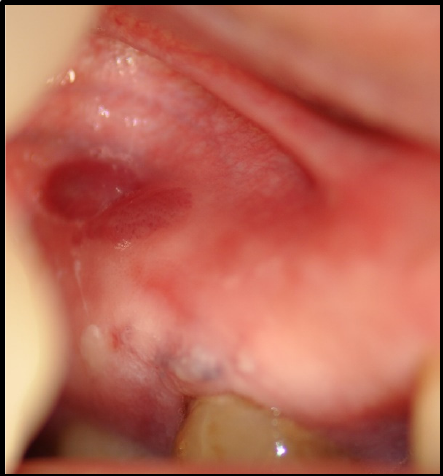
Figure 2. Hemorrhagic blisters, right buccal gingivae, consistent with benign mucous membrane pemphigoid. The patient, on pembrolizumab, presented with pain and dysphagia. Three patients had lesions which were exacerbations of previous oral and dermal lichen planus, and one had vitiligo. (Figure 3). Three patients presented with painful ul- cers following the use of mouthwash (Figure 4). The mouthwash was used to alleviate mild oral mucosal symptoms after the initiation of immunotherapy. Figure 3. Exacerbation of oral lichen planus; the biopsy was documented years before the cancer diagnosis. The patient, on pembrolizumab and switched to ipilimumab, presented with oral/gingi- val pain, bleeding, and the inability to perform oral hygiene.